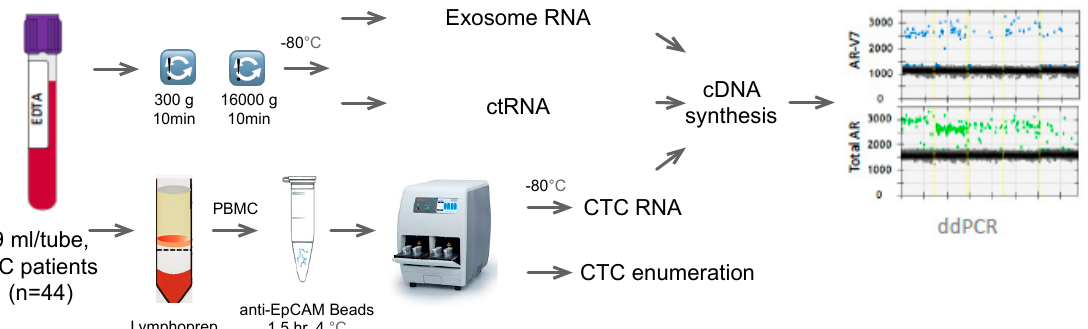
Figure 1. Work flow of the study. PC: prostate cancer, PBMC: peripheral blood mononuclear cells, ctRNA: circulating tumor ribonucleic acid, CTC: circulating tumor cell, cDNA: complementary deoxyribonucleic acid.